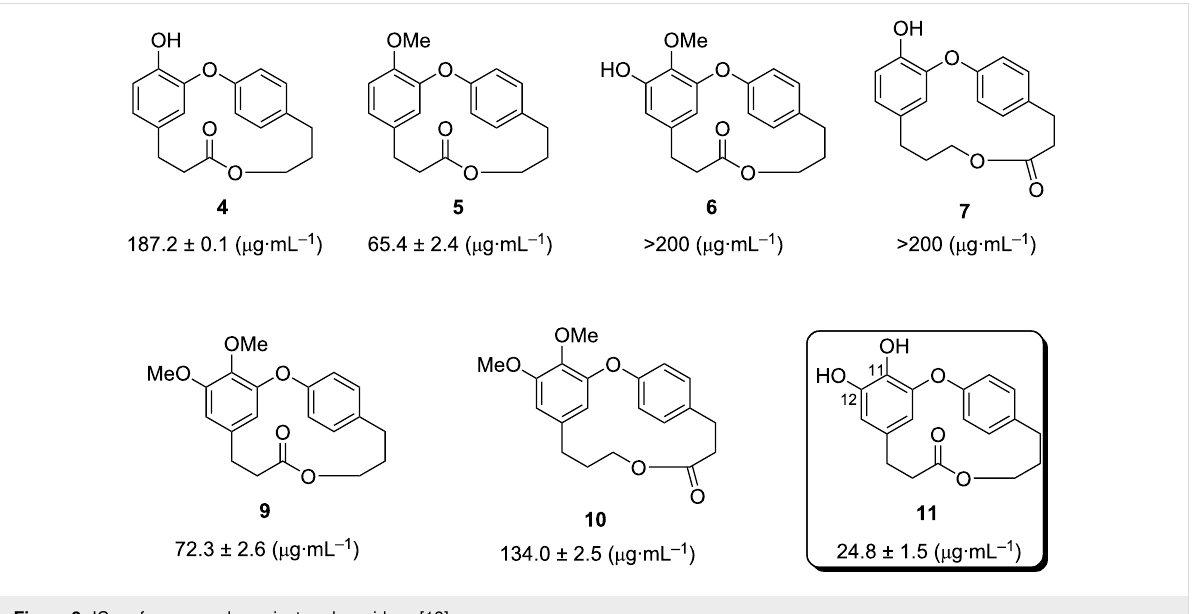
Figure 3: IC 50 of compounds against α -glucosidase